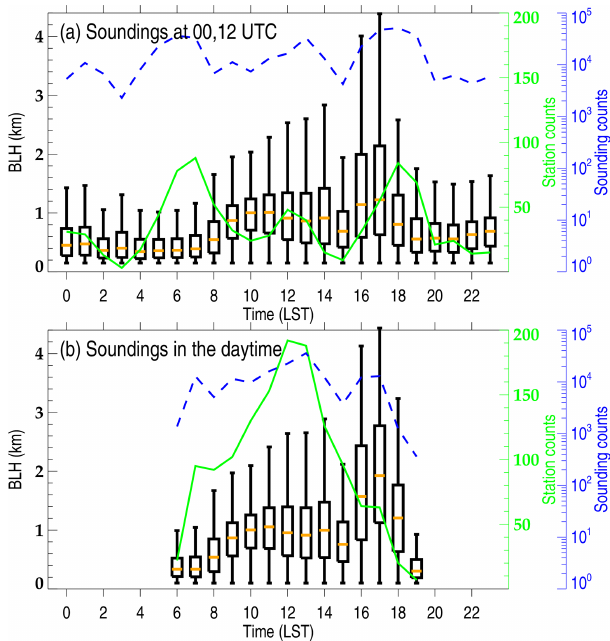
Figure 4. Box and whisker plots of diurnal variation (in LST, 24h) in BLH determined by all soundings operationally launched at 00:00 and 12:00UTC (a) and by the soundings launched at both synoptic times and intensive observation times that are limited to the daytime alone (b) . Solid green line and dotted blue line high- light the number of sonde stations and total soundings for each hour of day,